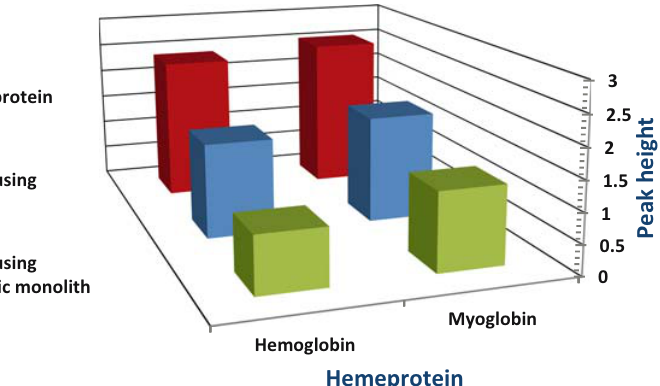
Figure 8: The average peak height of hemeproteins before and after enrichment using bare organic monolith and AgStNP – methacrylate polymeric monolith.